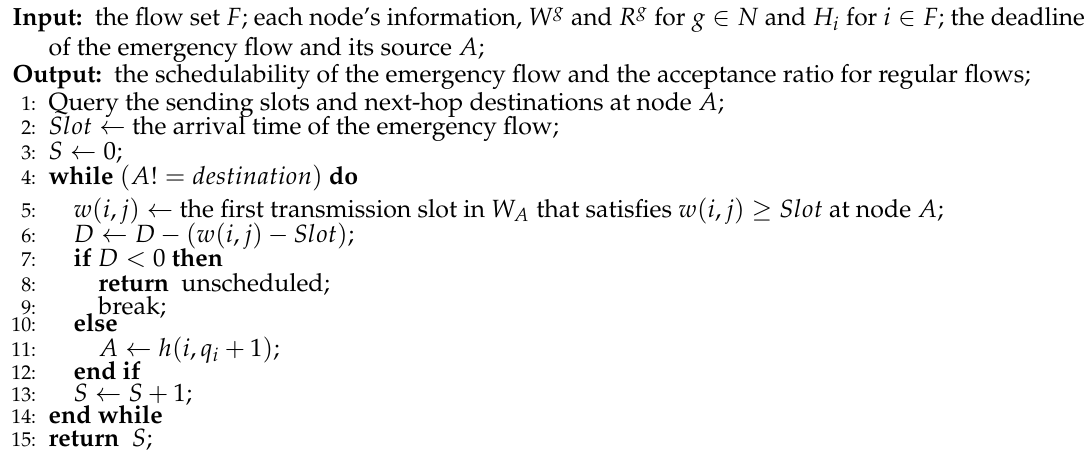
Algorithm 2 Stealing-first scheduling